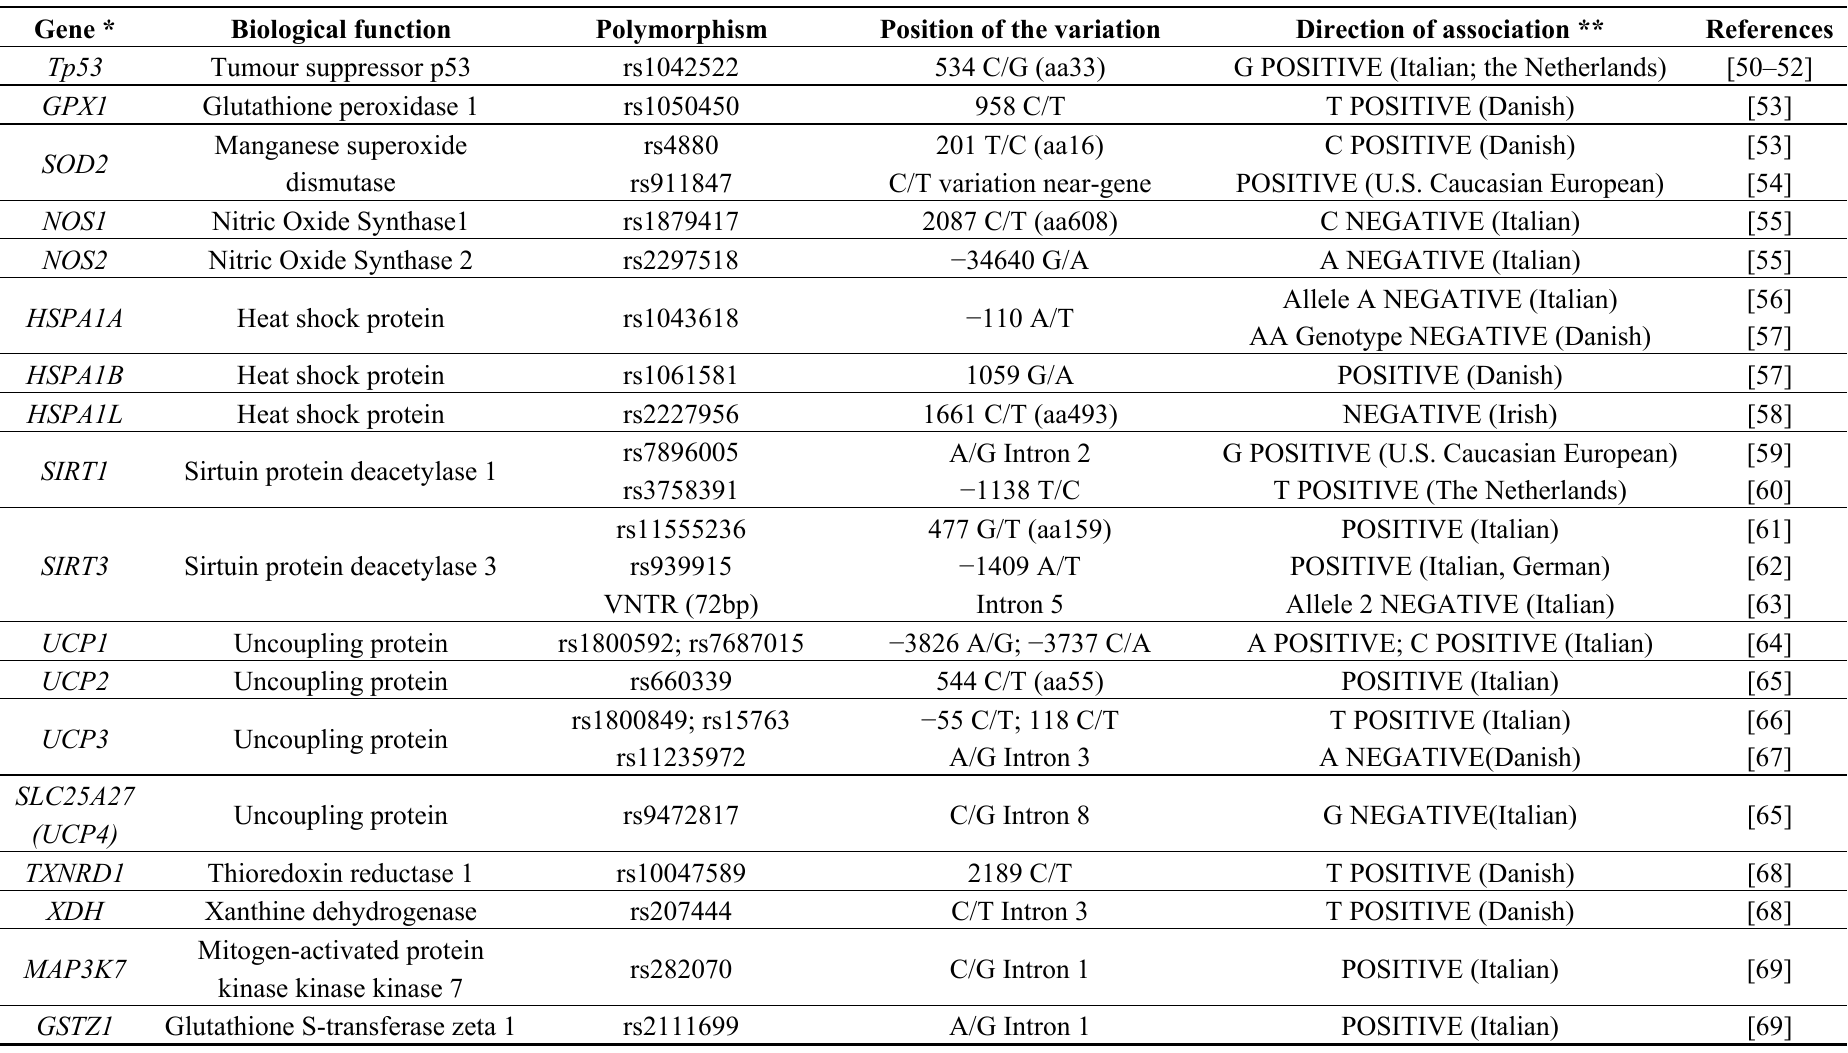
Table 1. Genes for which polymorphisms have been reported successfully associated at least in one study with human